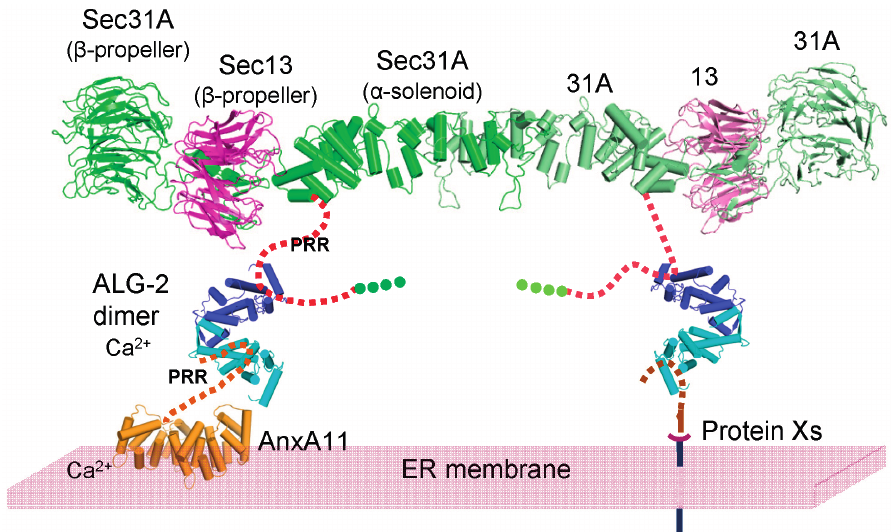
Figure 10. Model for the adaptor function of ALG-2 in anchoring the outer shell of coat complex II (COPII) at the endoplasmic reticulum (ER) membrane. An ALG-2 dimer (cyan and dark blue) bridges the assembly unit of the outer COPII shell and annexin A11 (AnxA11) on the ER membrane by binding a Pro-rich region (PRR) of Sec31A (red broken line) and that of AnxA11 (orange broken line) in the presence of Ca 2+ . An ALG-2 dimer may also directly or indirectly bind unknown proteins (Protein Xs, brown broken line representing the PRR of a putative ALG-2-interacting protein and black line representing an ER-transmembrane tethering protein) on the ER membrane to facilitate anchoring of the COPII coat. For simplification of the diagram, the Sec23/Sec24 inner coat cage is not shown, and only one heterotetrameric unit of Sec31A (green and pale green) and Sec13 (magenta and pink) is illustrated. A 3D-structural model of human Sec31A (UniProt: O94979) was generated by the SWISS-MODEL program using a yeast Sec31/Sec13 heterotetramer model ([43]; PDB code: 4BZJ, chain A) as a template for the N -terminal β -propeller and central α -solenoid domains. The Pro-rich region (PRR, broken red line) and the C -terminal α -solenoid domain (green dotted line) are predicted to be outside the architectural core of the assembly unit [44]. The β -propeller structure of human Sec13 is taken from PDB Code 3BG0, chain A. The core domain of human AnxA11 (UniProt: P50995) was modeled using the bovine AnxA4 structure (PDB code: 1ANN) as a